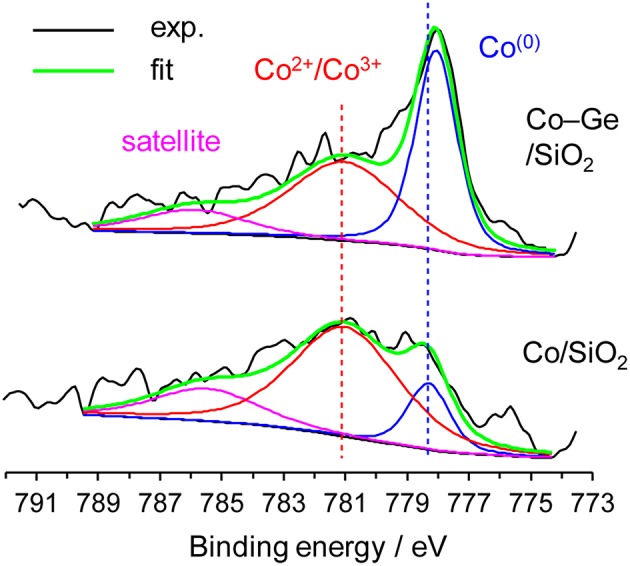
Co 2p3/2 XPS of Co/SiO2 and Co–Ge/SiO2 catalysts.